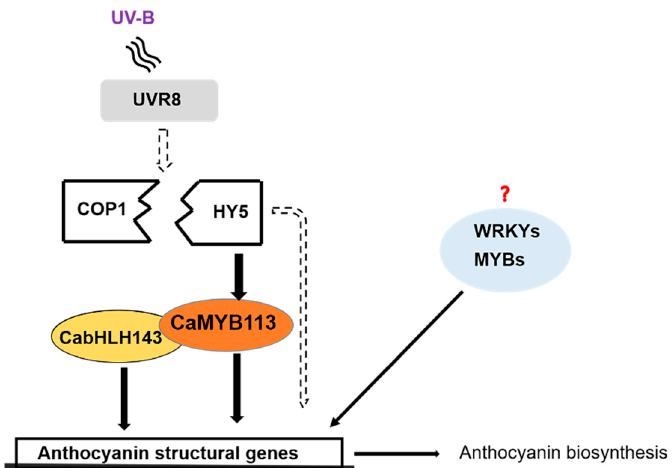
Figure 6. A hypothetical model of UV-B-induced anthocyanin biosynthesis in pepper fruit. A UV-B signal activates the UVR8 receptor-forming monomer, which binds to the COP1 protein and releases HY5. HY5 not only binds directly to the anthocyanin structural genes but also upregulates the expression of CaMYB113. CaMYB113 and CabHLH143 may regulate the expression of several anthocyanin structural genes by forming a complex. The above processes ultimately promote the accumulation of anthocyanins. In addition, some TFs that may be involved in the regulation of anthocyanin structural genes still need to be studied in depth. (The solid line represents the results of this study, and the dotted line represents those of previously reported studies.).